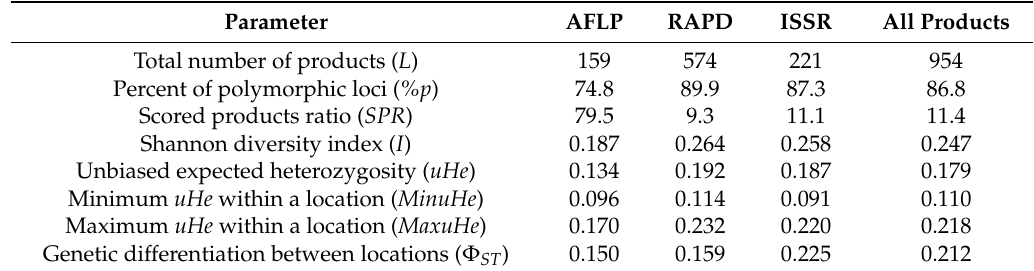
Table 1. Marker systems efficiency for analysis of genetic diversity in S. purpurea using AFLPs (amplified length polymorphisms), RAPDs (randomly amplified polymorphic DNA) and ISSRs (inter-simple sequence repeats) and a combination of all marker systems.